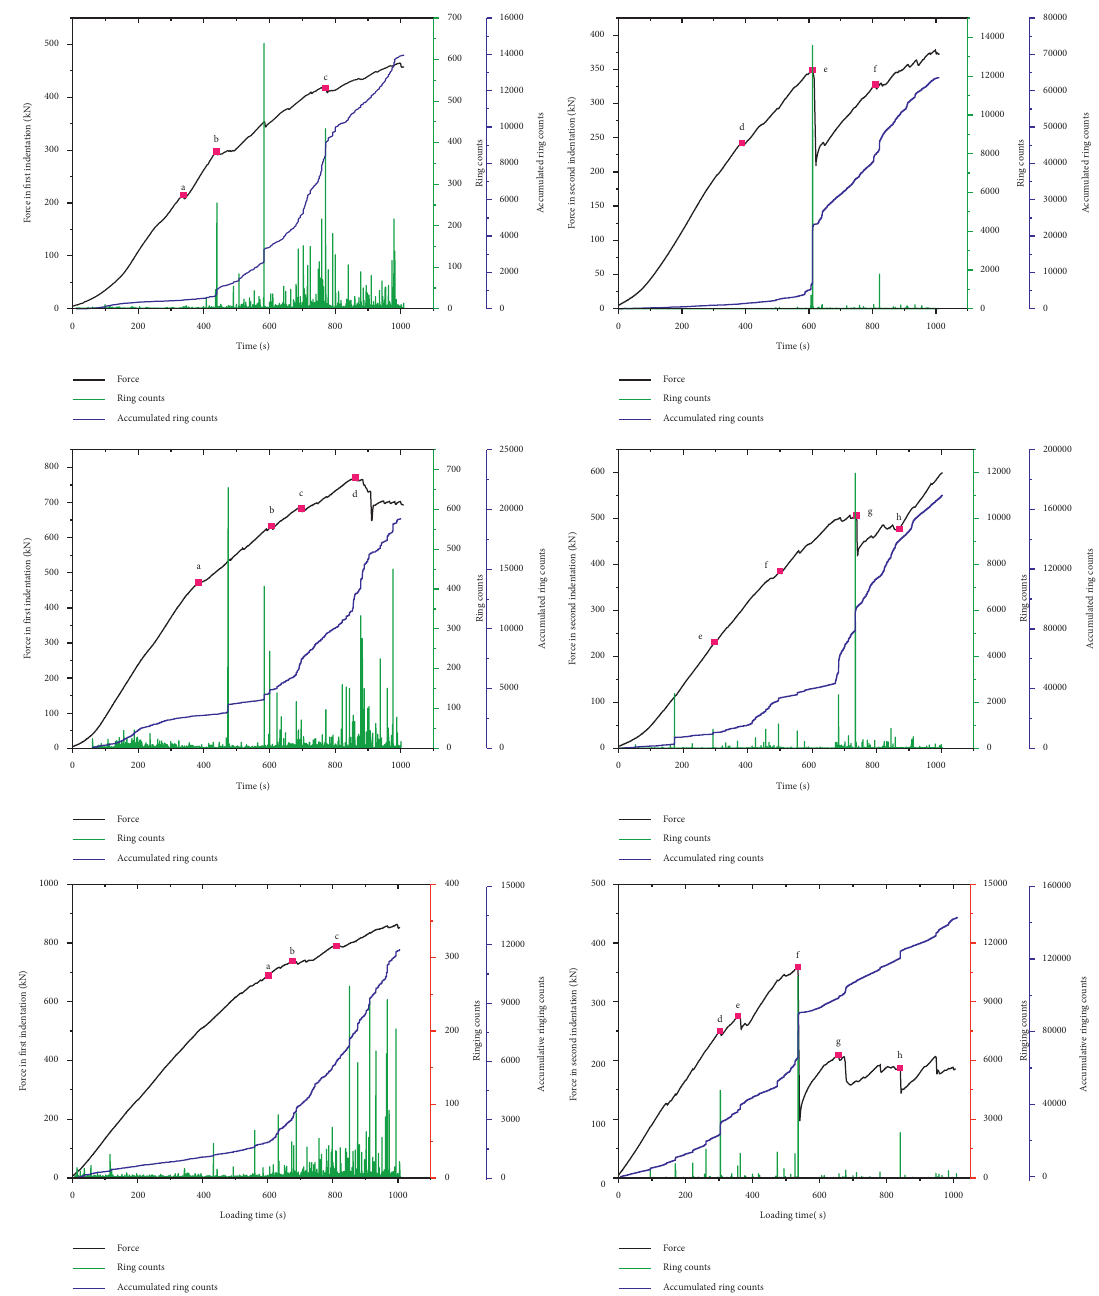
Figure 8: Acoustic emissions for the α � 30 ° , α � 60 ° , and α � 90 ° specimens under various confining